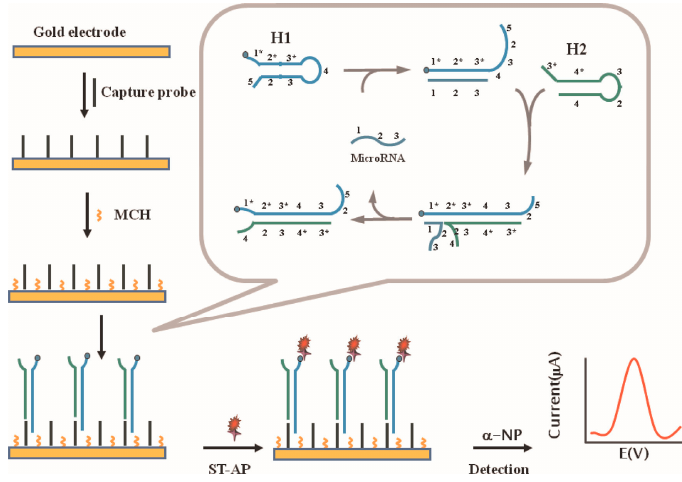
Figure 14. Principle of miRNA electrochemical detection based on mismatched catalytic hairpin assembly amplification [114]. Copyright 2015. Reproduced with permission from Elsevier B.V.